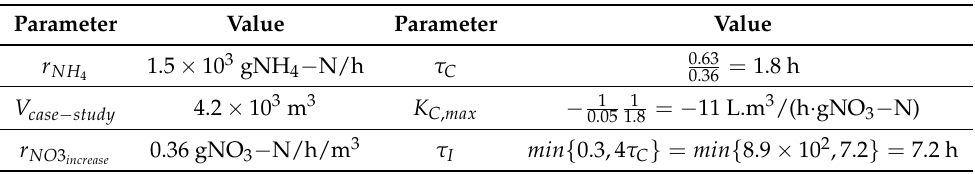
Table 3. Parameter values for the industrial case-study